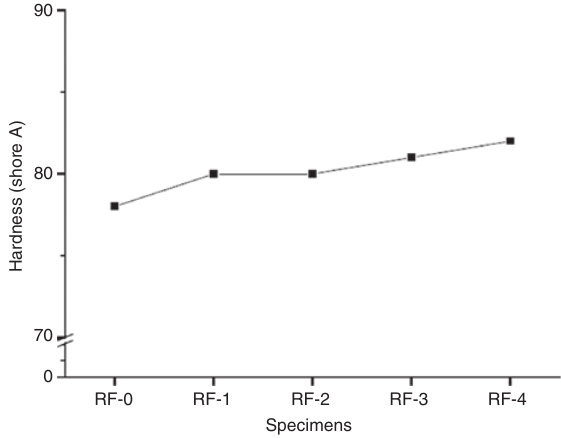
Figure 6 Crack growth and bending frequency of CR composites with a differing number of tire-cord layers and arrangement